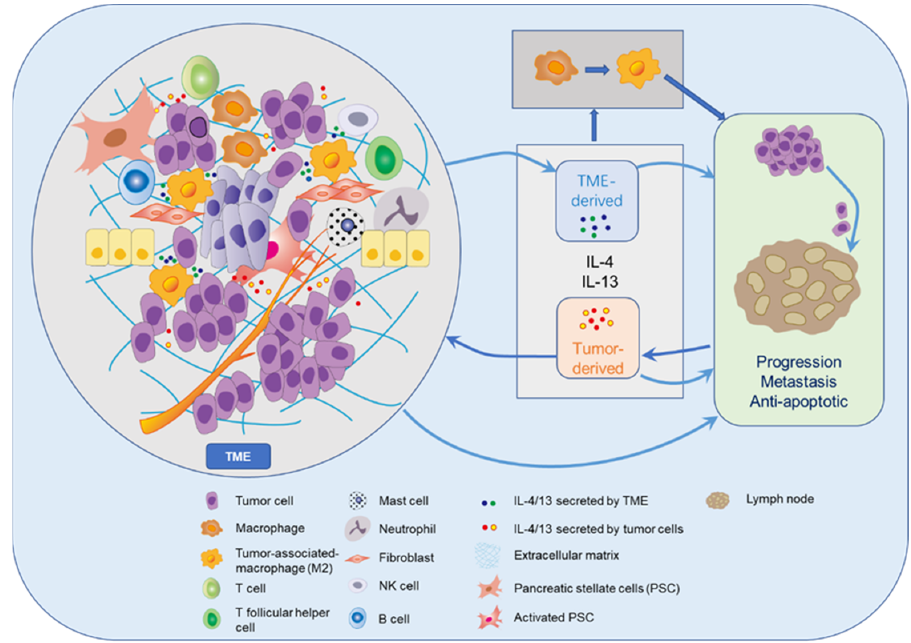
Figure 3. Tumor microenvironment (TME) and role of IL-4/IL-13 in tumor